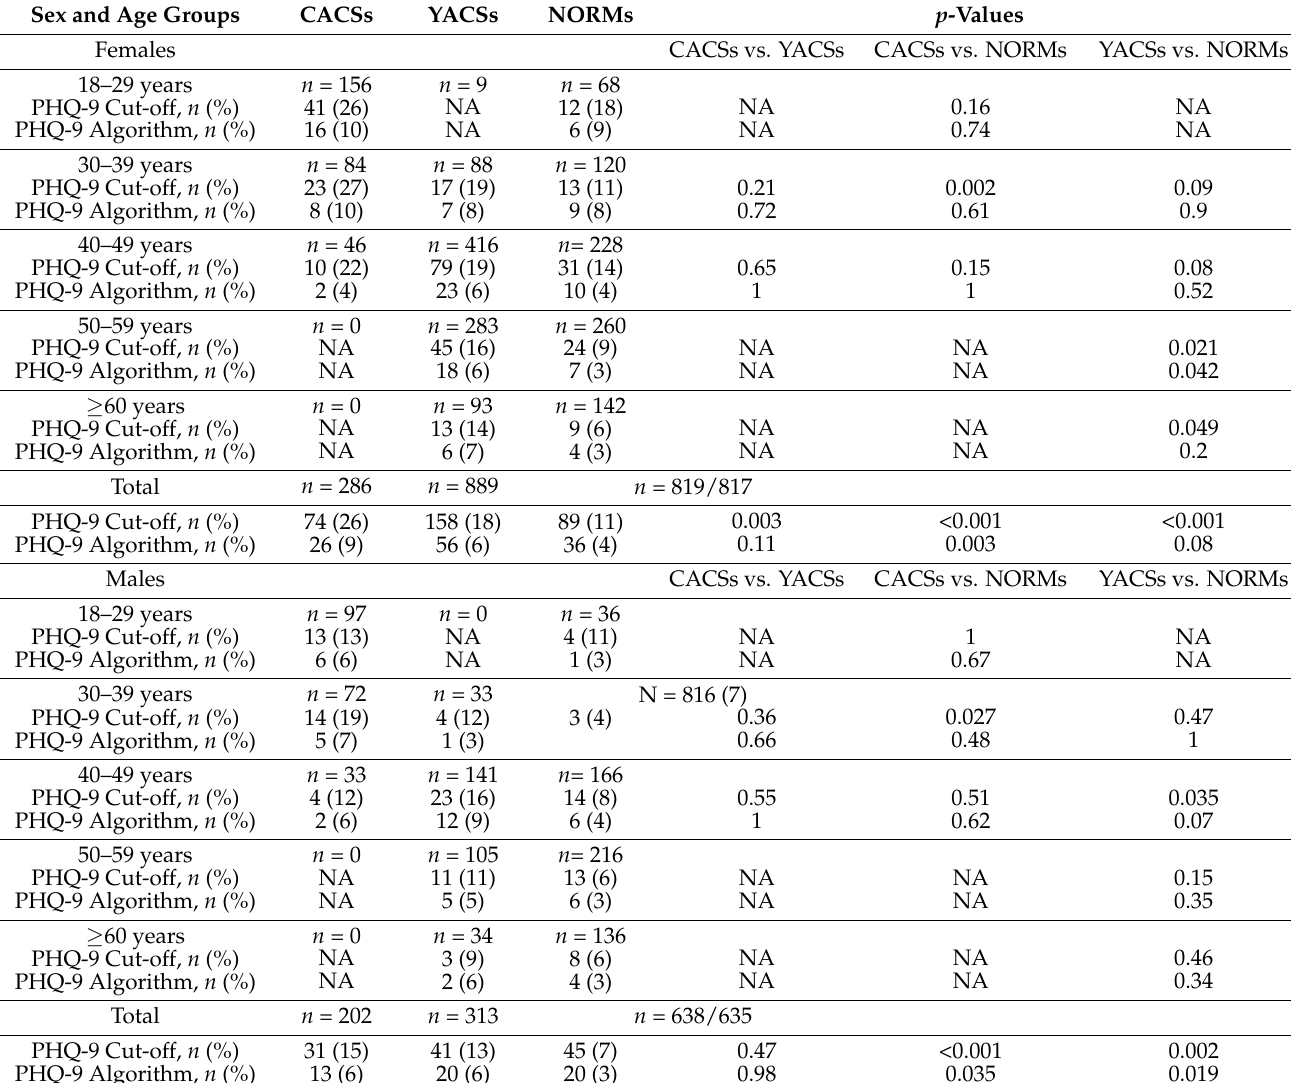
Table 2. Prevalence rates of possible MDE according to the cut-off and the algorithm definitions of PHQ-9 in sex and age groups among CACSs, YACSs, and